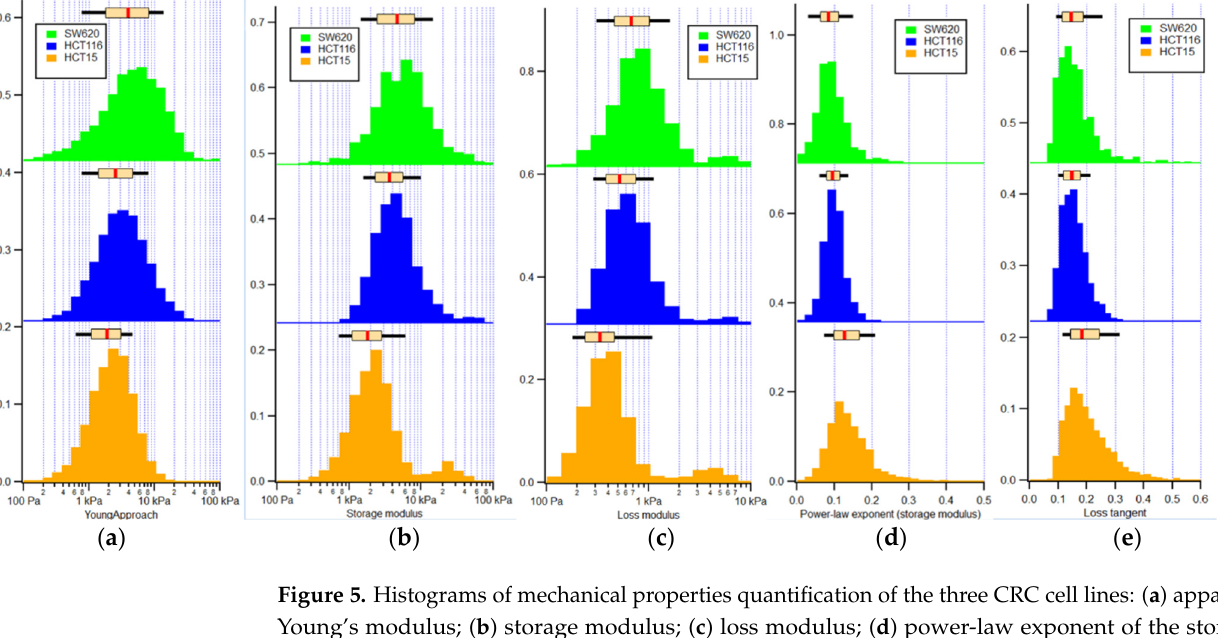
Table 1. Values of median and percentiles of Young’s modulus, storage modulus, loss modulus, power-law exponent applied to the storage modulus, and loss tangent quantification determined by AFM of HCT15, HT116, and SW620 cell lines.